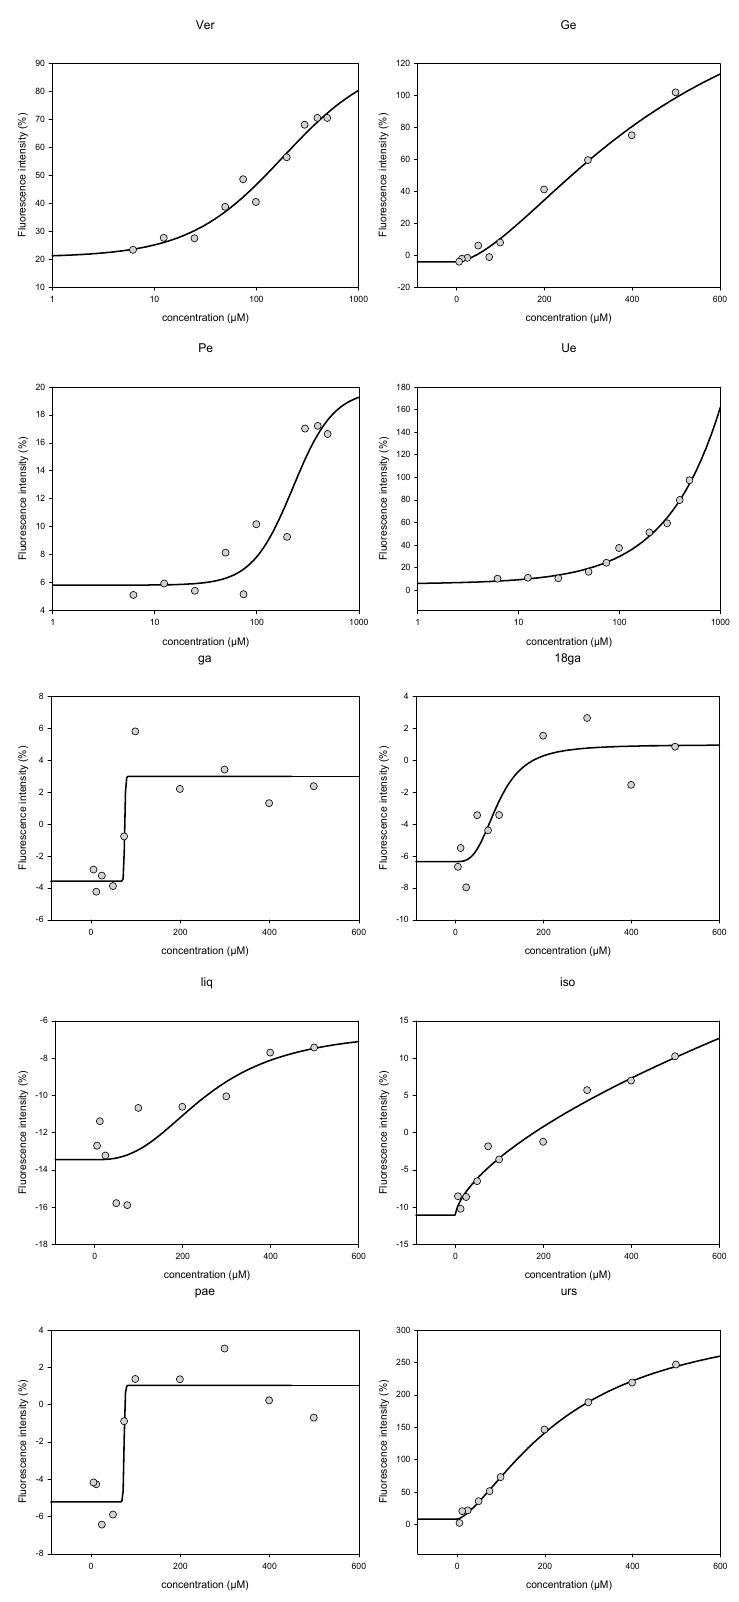
Figure 4. Fluorescence intensity of rhodamine 123 in Caco-2 cells after 5 h treatment with a single substance. Verapamil was used as a positive control. All data were from at least three experiments represented as the mean ±